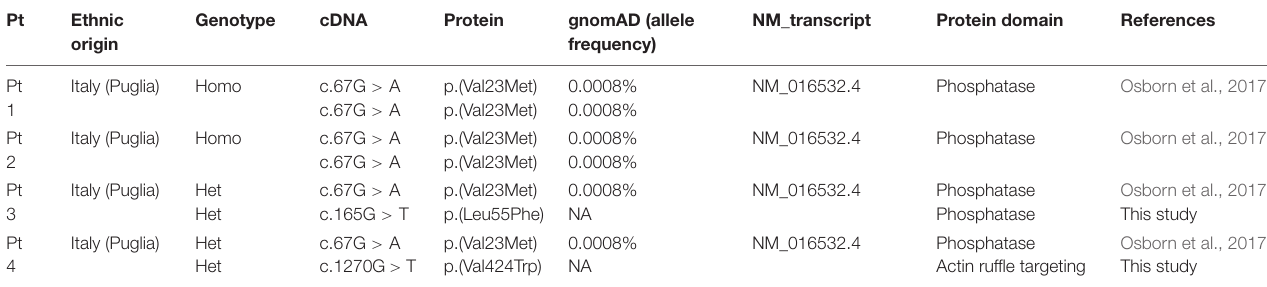
TABLE 2 | Summary of pathogenic variants identified in this